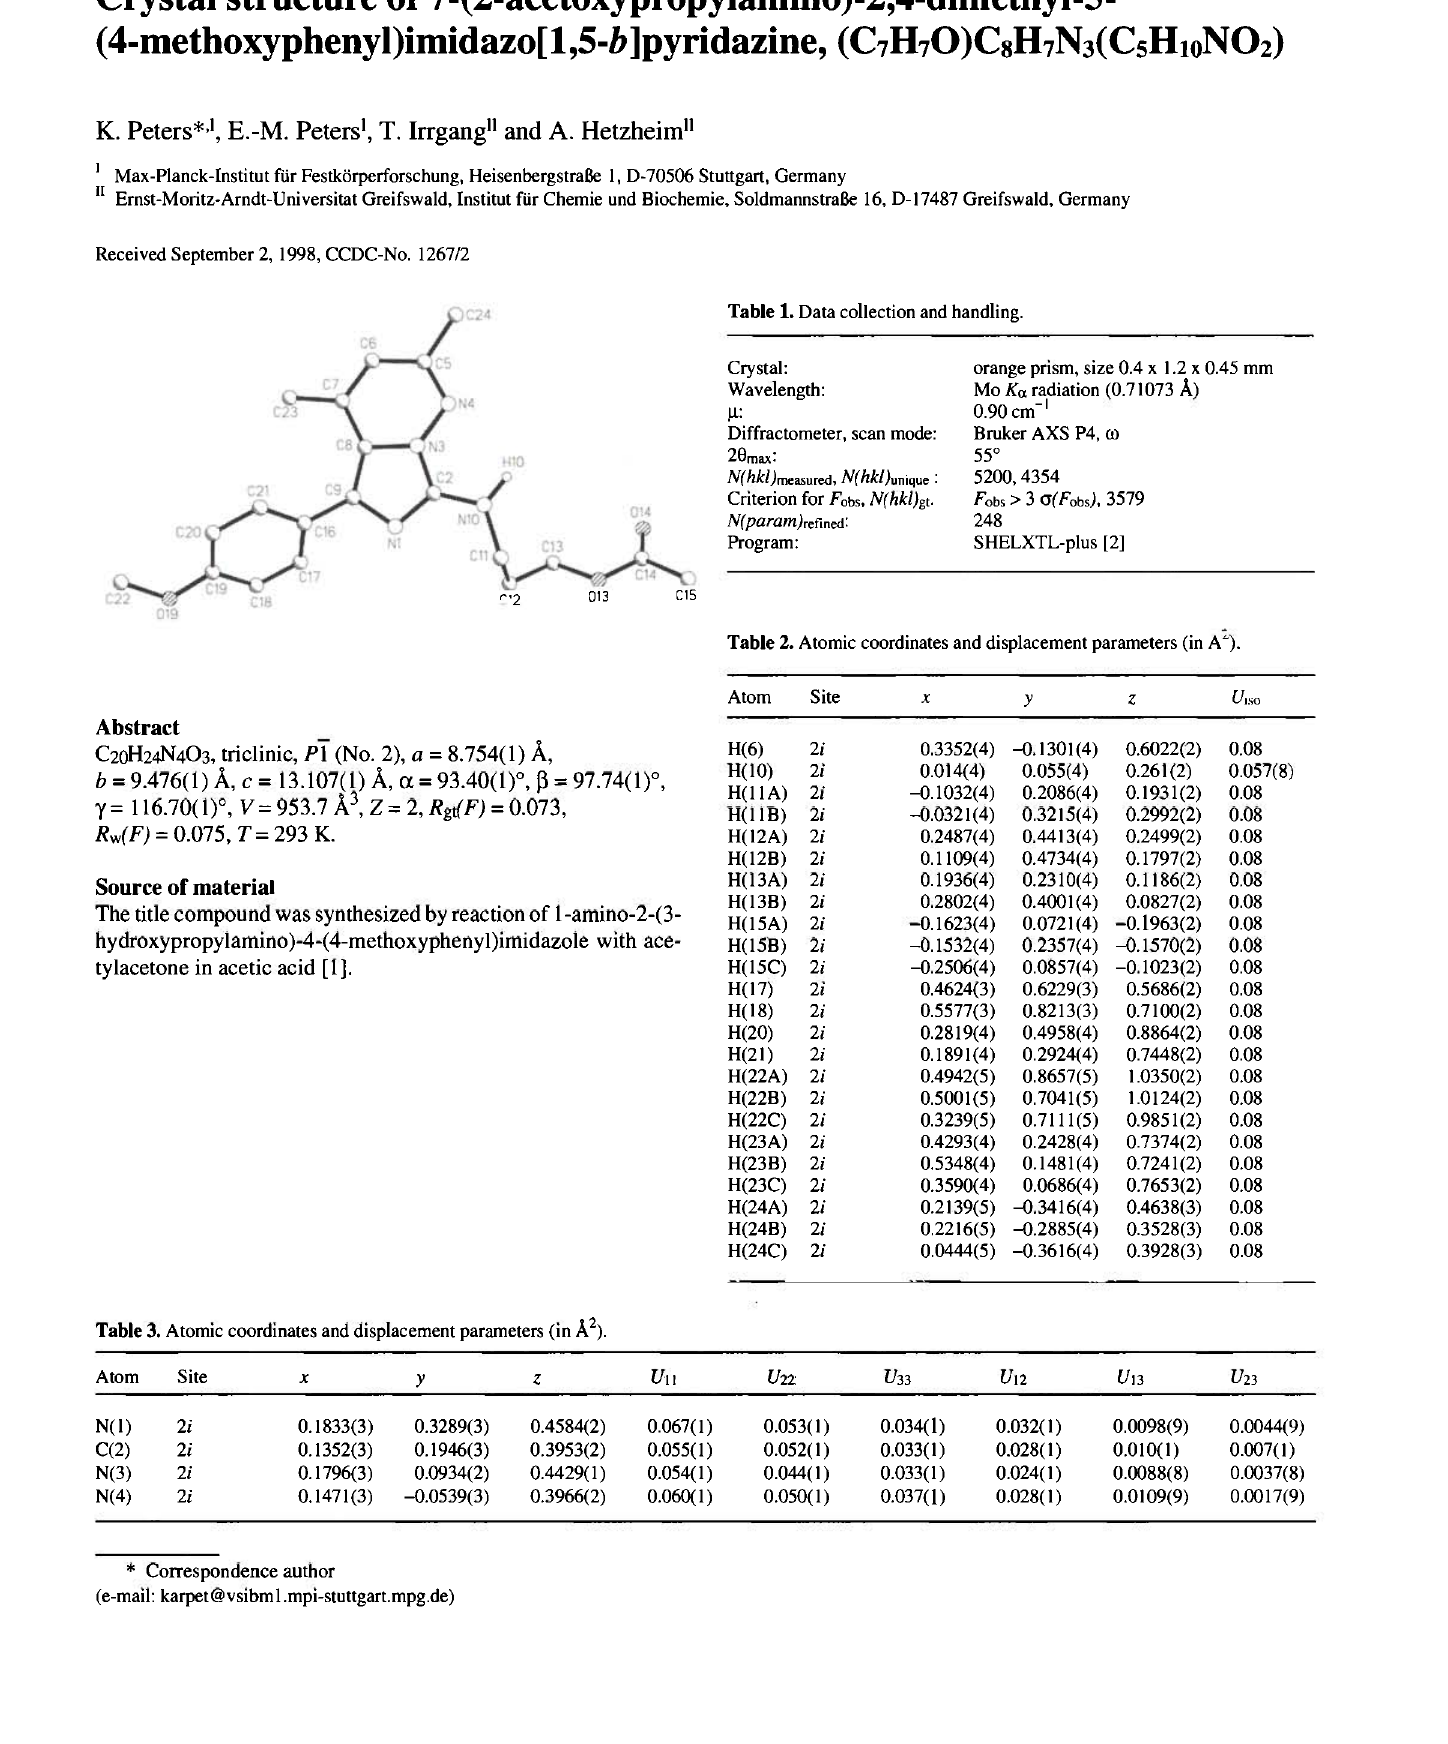
Table 3. Atomic coordinates and displacement parameters (in A 2